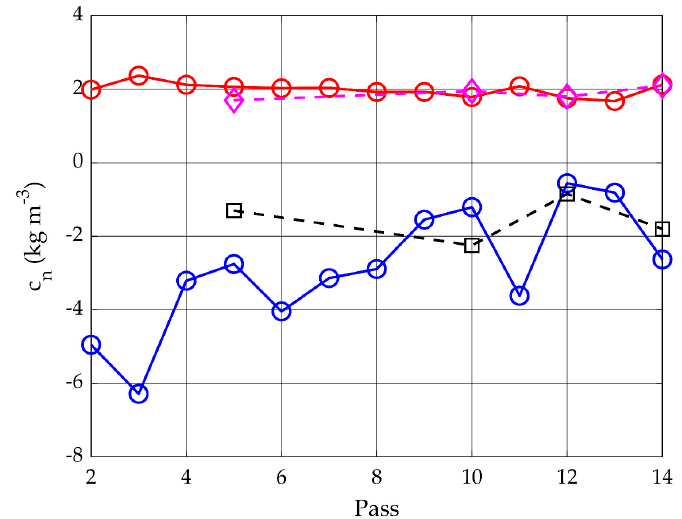
Figure 16 . Residuals from the model B = c 0 H + c 1 R 1 , for Pass 6 from Transect 3. Figure 16. Residuals from the model B = c